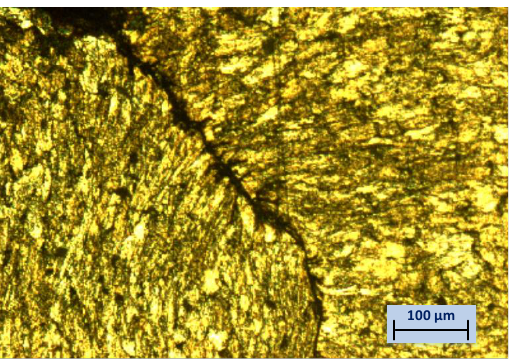
Figure 10. Microstructure of the folded defects when stamping the head of the sample in the one- step process.